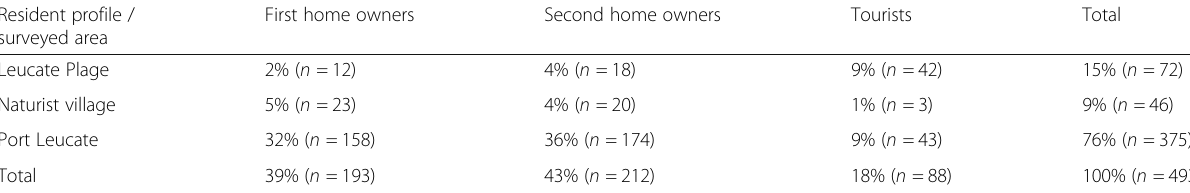
Table 3 Breakdown of surveys in Leucate based on area of residence and residential profile of individual surveyed Resident profile / surveyed